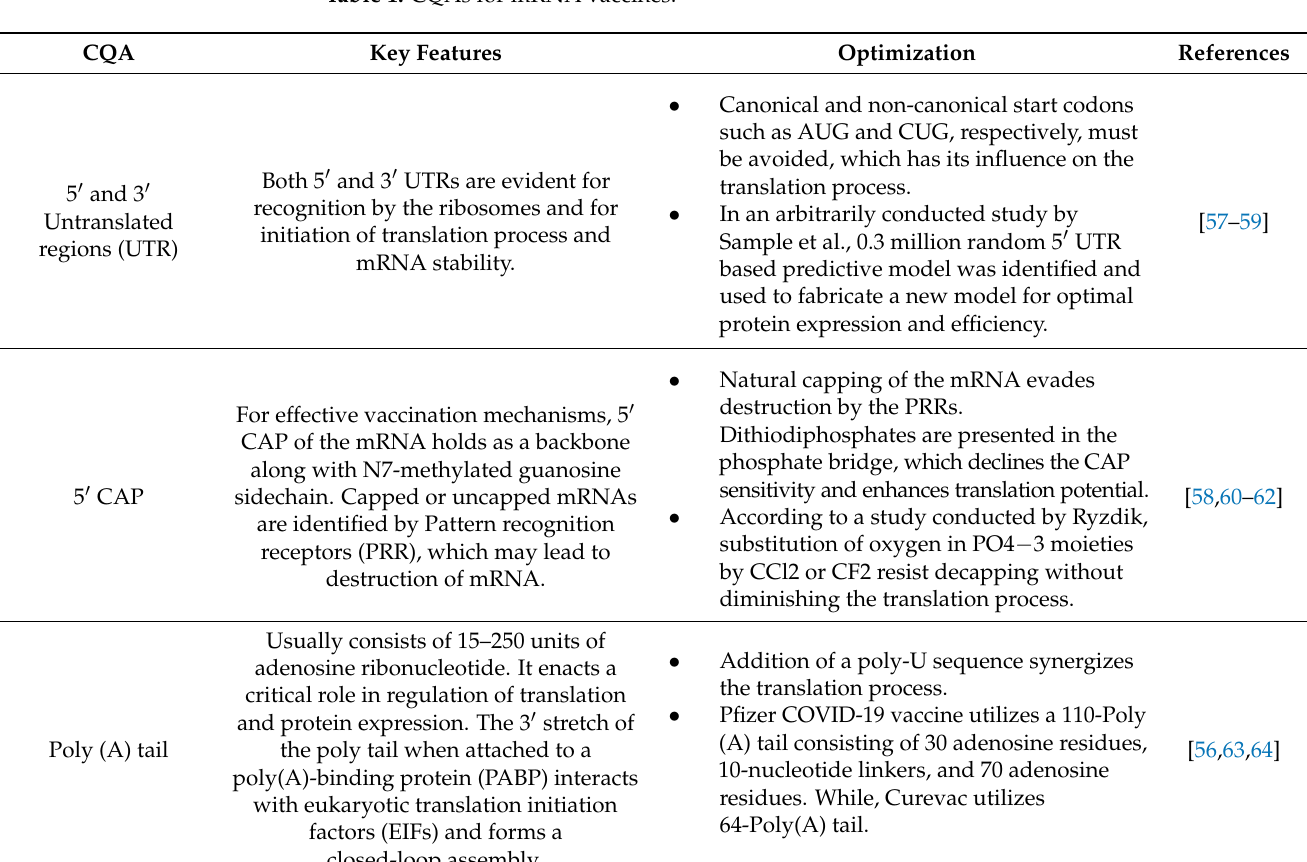
Table 1. CQAs for mRNA